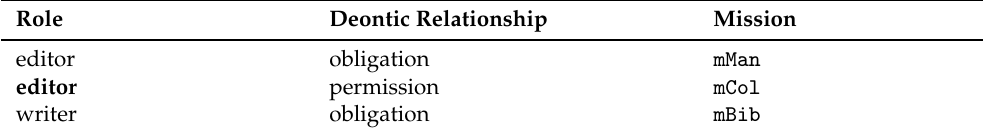
Table 8. Deontic specification for a simulation example—permission for an agent not eligible for the